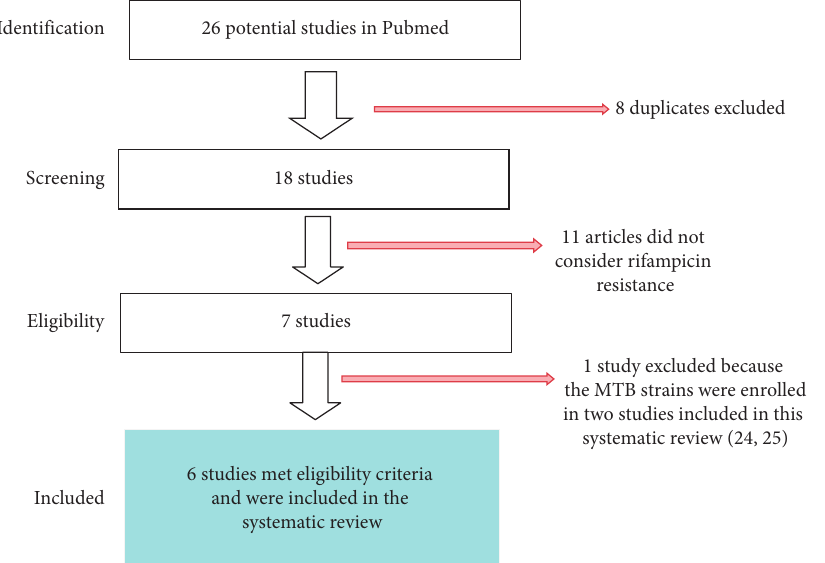
Figure 1: Flow diagram illustrating study